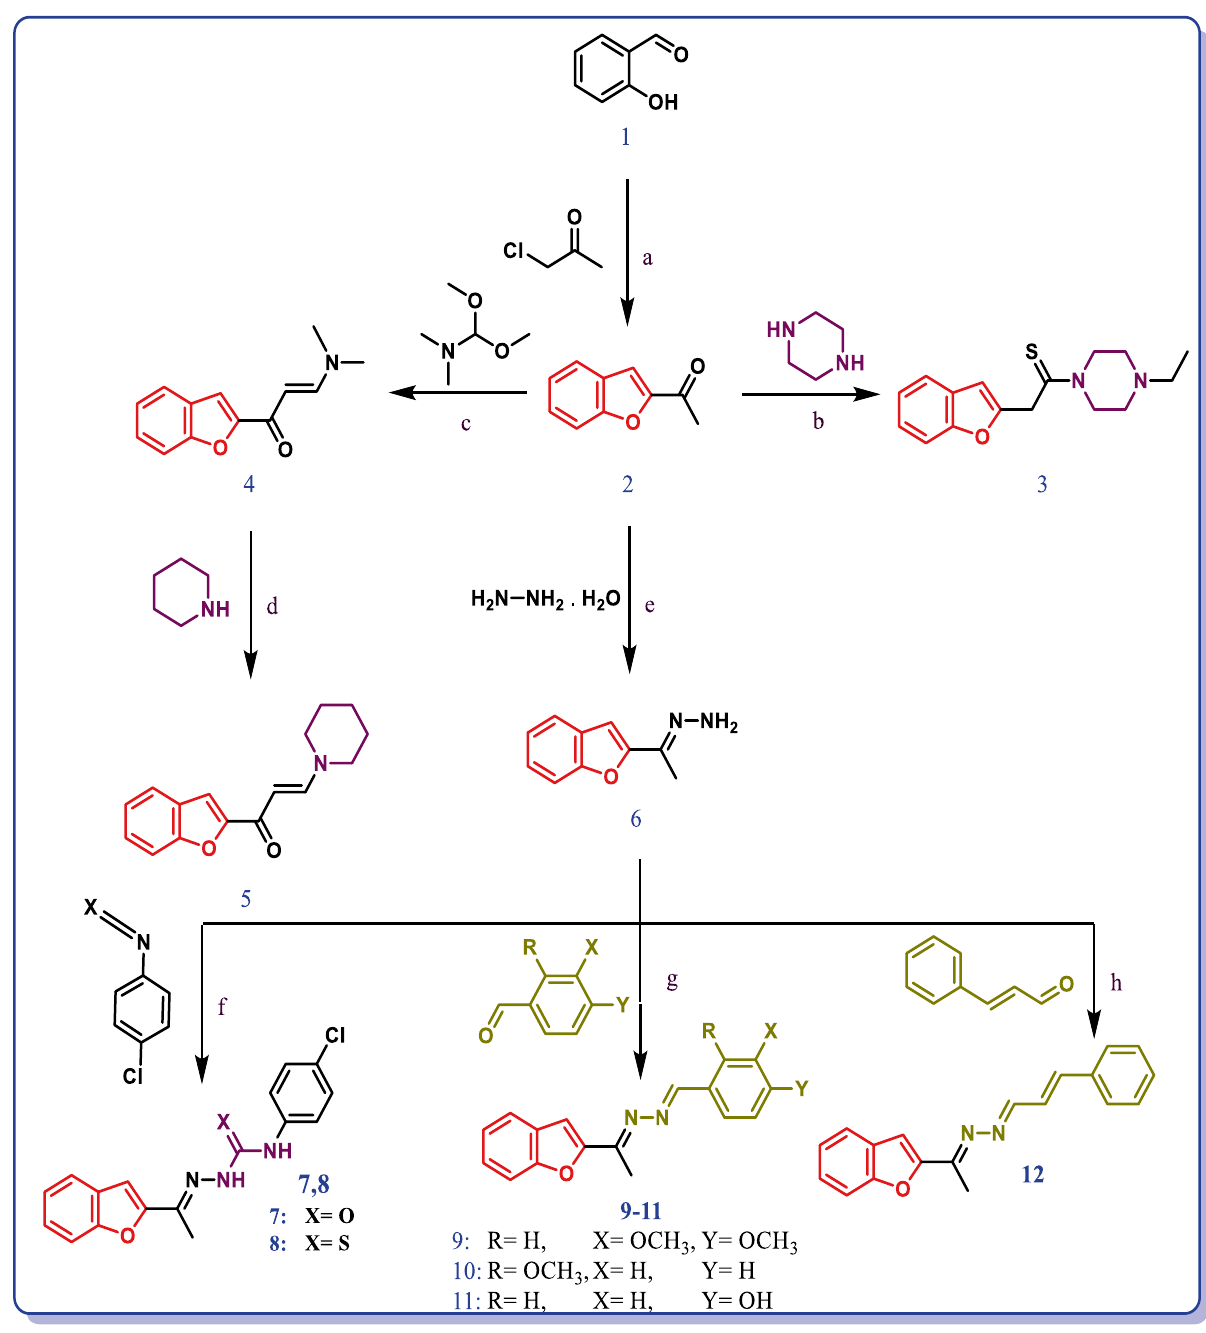
reflux; and ( h ) glacial CH 3 COOH,